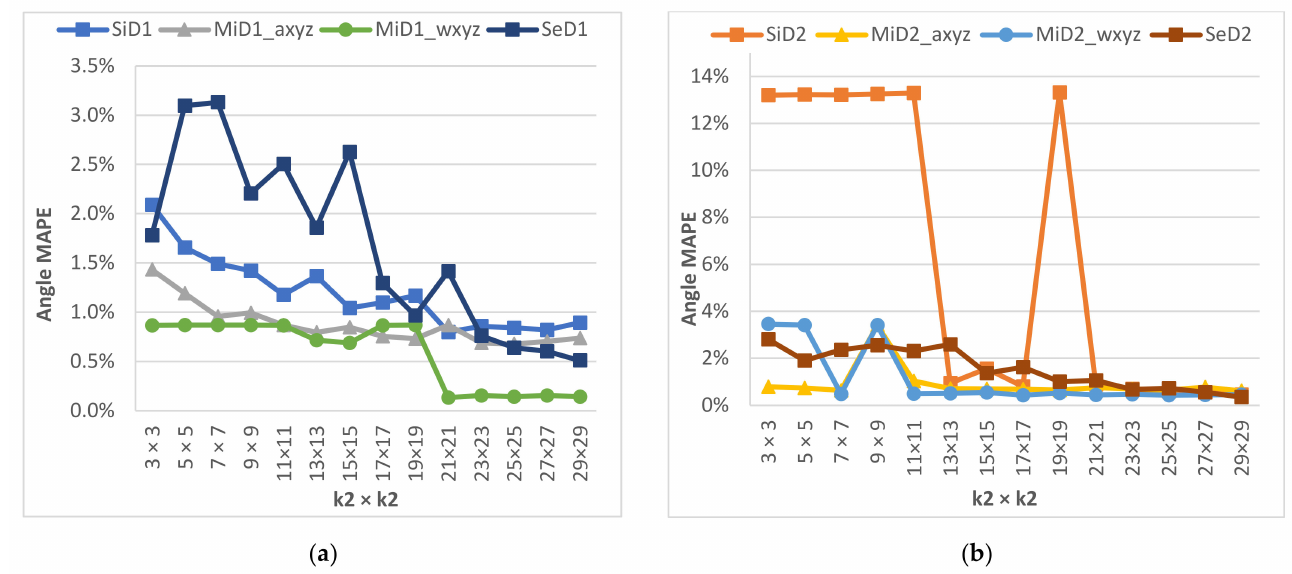
Figure 11. MAPE trends for steering wheel angle prediction of the architectures type 1 and type 2 with convolutional blocks